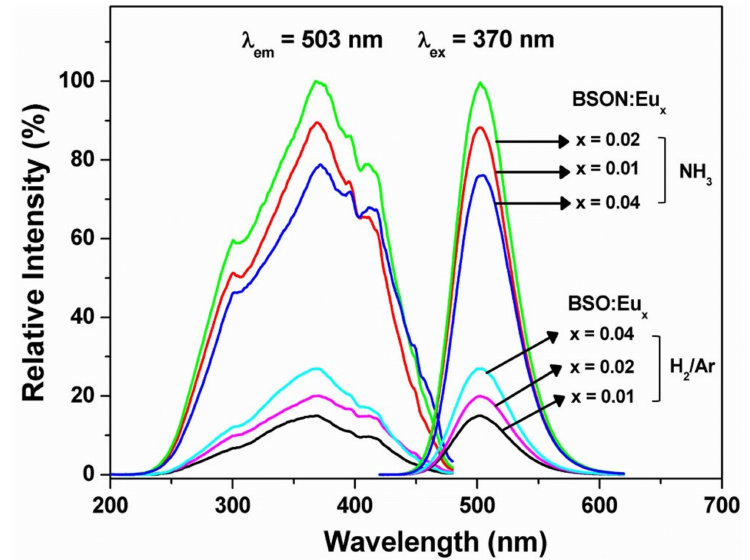
Figure 8. PL spectra of BSO:Eu 2 + x (at 1250 ◦ C under 4% H 2 –Ar) and BSON:Eu 2 + x (at 1150 ◦ C under NH 3 ) phosphors synthesized with the variation of Eu